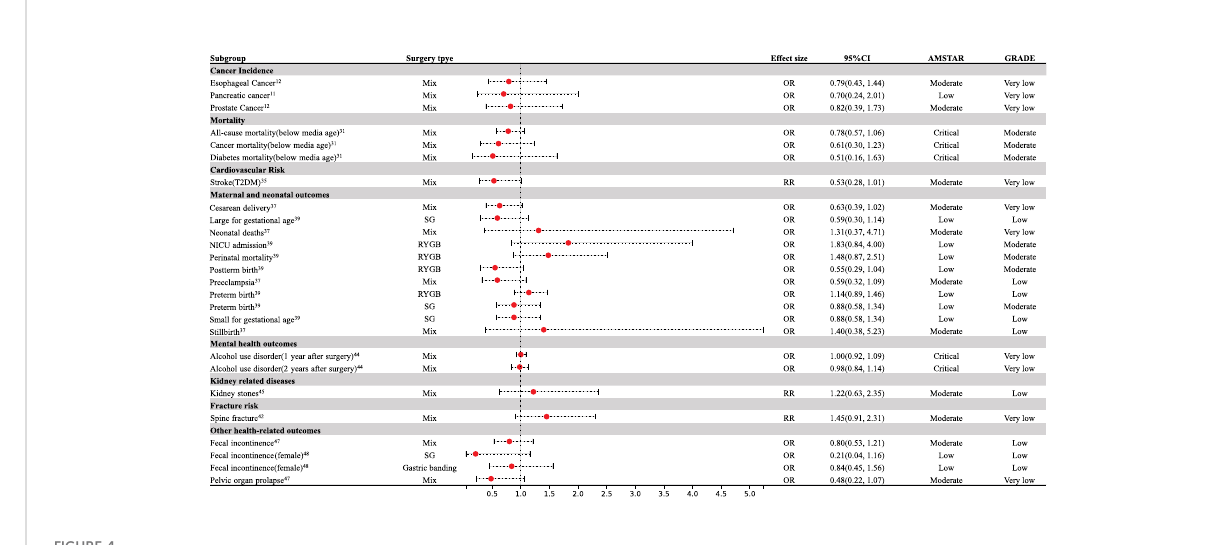
FIGURE 4 Forest plot of non-signi fi cant associations with bariatric surgery. CI, con fi dence interval; T2DM, type 2 diabetes mellitus; RYGB, Roux-en-Y gastric bypass; SG, Sleeve Gastrectomy; NICU, neonatal intensive care